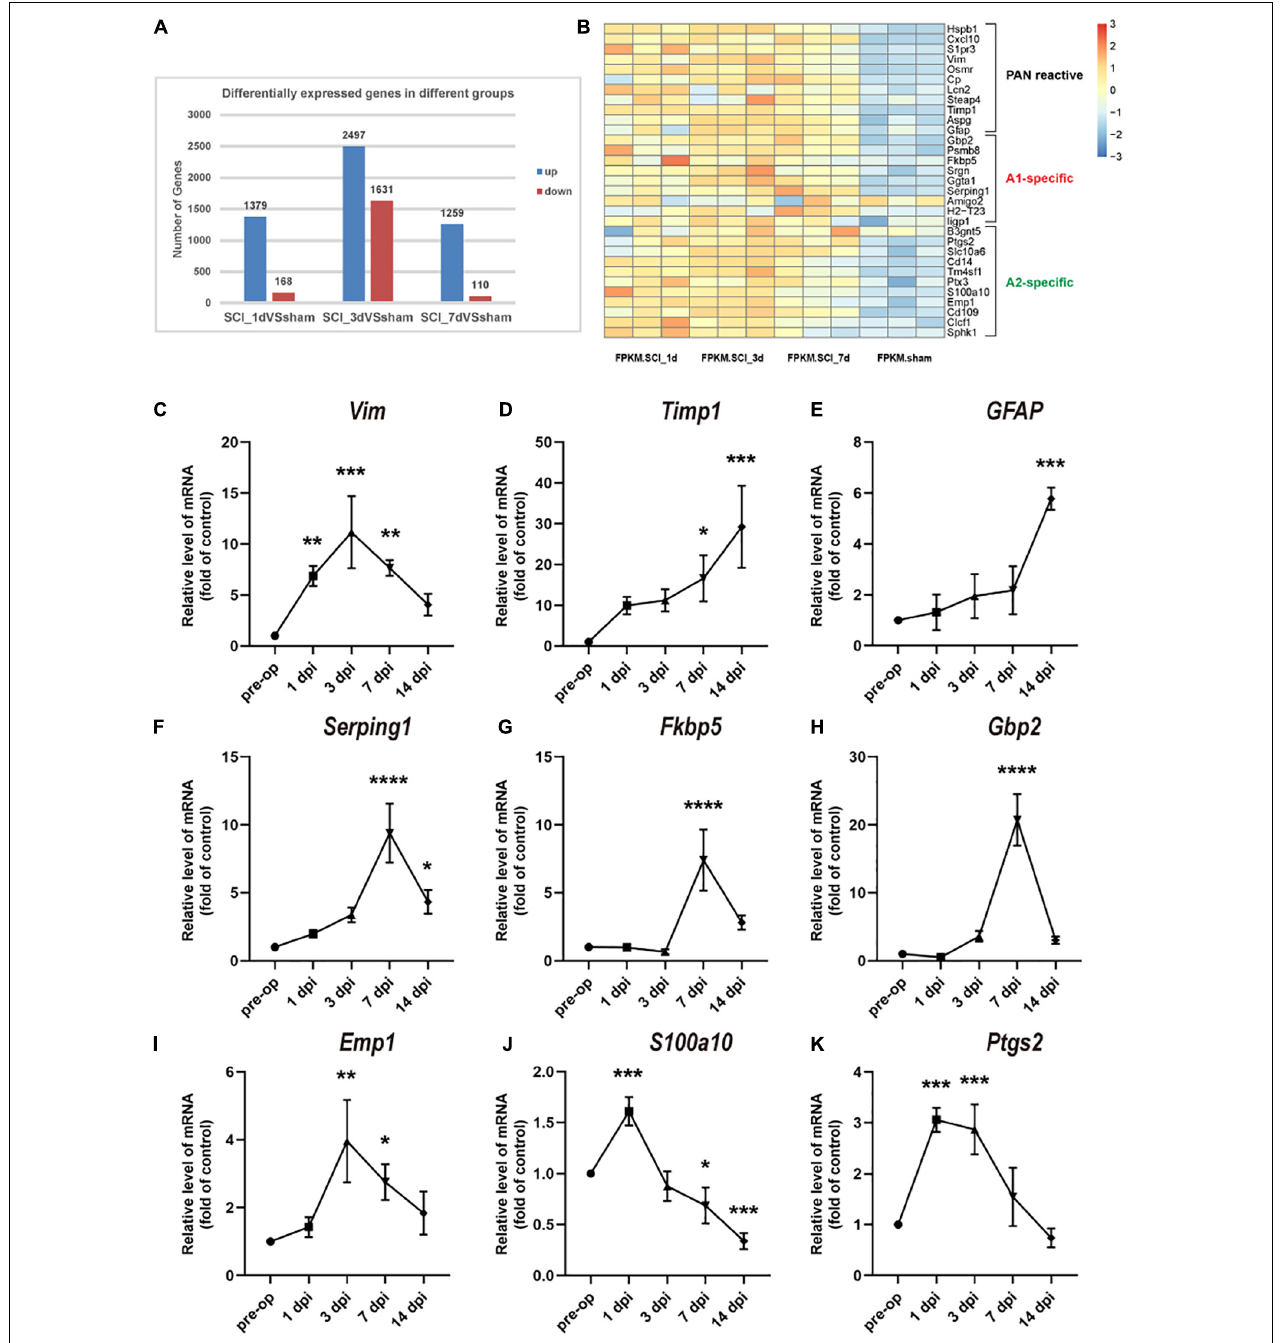
FIGURE 2 | Changes in astrocyte-specific transcript levels after SCI. (A) The number of differentially expressed genes in the control, SCI-1d, SCI-3d, and SCI-7d groups. (B) A heatmap of selected significantly changed PAN-reactive, A1-specific, and A2-specific genes. (C–E) Fold changes in the levels of the representative PAN-reactive transcripts (Vim, Timp1, and GFAP) at each time point after SCI. (F–H) Fold changes in the levels of the representative A1-specific reactive transcripts (Serping1, Fkbp5, and Gbp2) at each time point after SCI. (I–K) Fold changes in the levels of the representative A2-specific transcripts (Emp1, S100a10, and Ptgs2) at each time point after SCI. N = 3 individuals per group. * p < 0.05, ** p < 0.01, *** p < 0.001, **** p < 0.0001 vs. the sham control group.